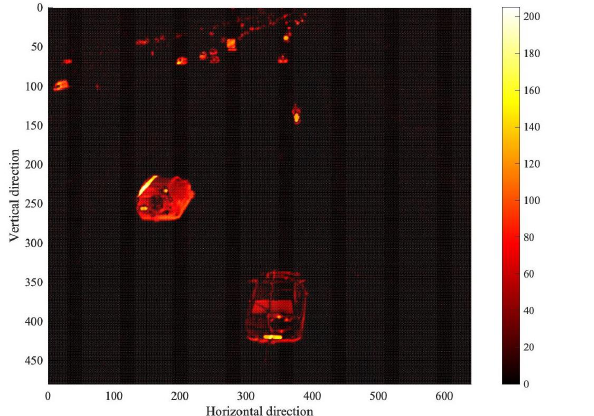
Figure 4. Mapped gray-mode result of background